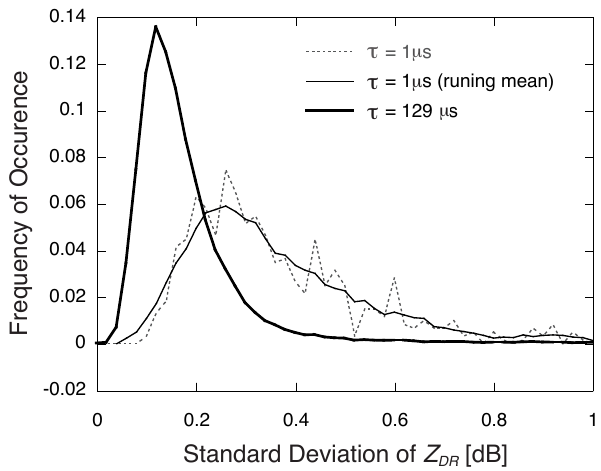
Fig. 1. Distribution of the standard deviation of differential reflec- Figure 1. Distribution of the standard deviation of differential reflectivity ( Z DR ) for samples collected in tivity ( Z DR ) for samples collected in stratiform rain by the MRI stratiform rain by the MRI C-band polarimetric radar. Signals greater than or equal to the signal minimum C-band polarimetric radar. Signals greater than or equal to the sig- level + 20 dBm were used. The peaks measured were 0.26 dB for short-pulse observations ( (cid:434) (cid:3)(cid:32)(cid:3)(cid:20)(cid:3)(cid:427)(cid:86)(cid:12)(cid:3)(cid:68)(cid:81)(cid:71)(cid:3)(cid:19)(cid:17)(cid:20)(cid:21)(cid:3) nal minimum level + 20dBm were used. The peaks measured were dB for long-pulse observations ( (cid:434) (cid:3)(cid:32)(cid:3)(cid:20)(cid:21)(cid:28)(cid:3)(cid:427)(cid:86)(cid:12)(cid:15)(cid:3)(cid:85)(cid:72)(cid:86)(cid:83)(cid:72)(cid:70)(cid:87)(cid:76)(cid:89)(cid:72)(cid:79)(cid:92)(cid:17) 0.26dB for short-pulse observations ( τ =1µs) and 0.12dB for long- pulse observations ( τ =129µs),